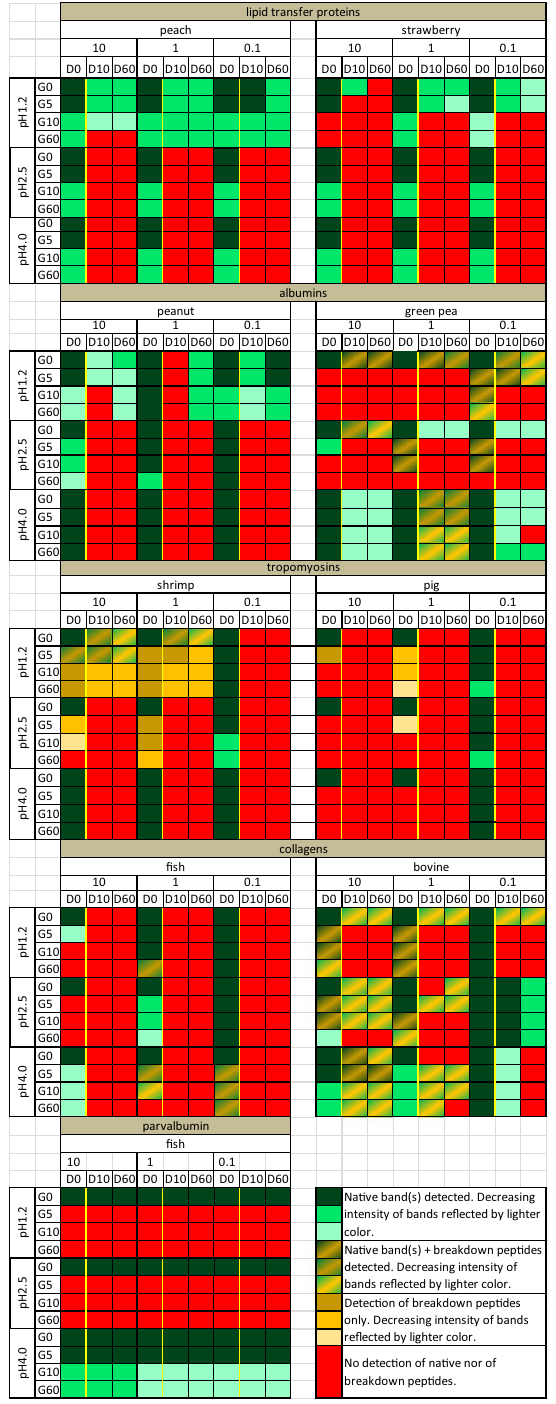
Table 2 Schematic overview of resistance to digestion judged by